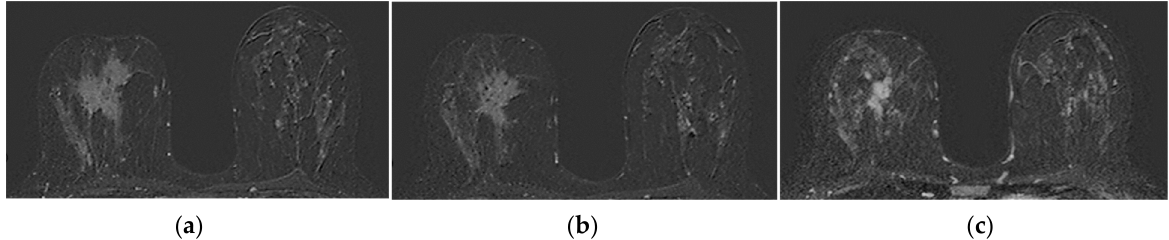
Figure 6. Partial pathological response (PR): large spiculated neoplastic lesion (4.5 cm) in right retroareolar (HER2 +) with moderate contralateral BPE in the pretreatment baseline image ( a ). Progressive reduction of lesion diameter is observed to 50% in step I MRI ( b ) and to 75% in step II MRI ( c ) without significant changes in BPE.